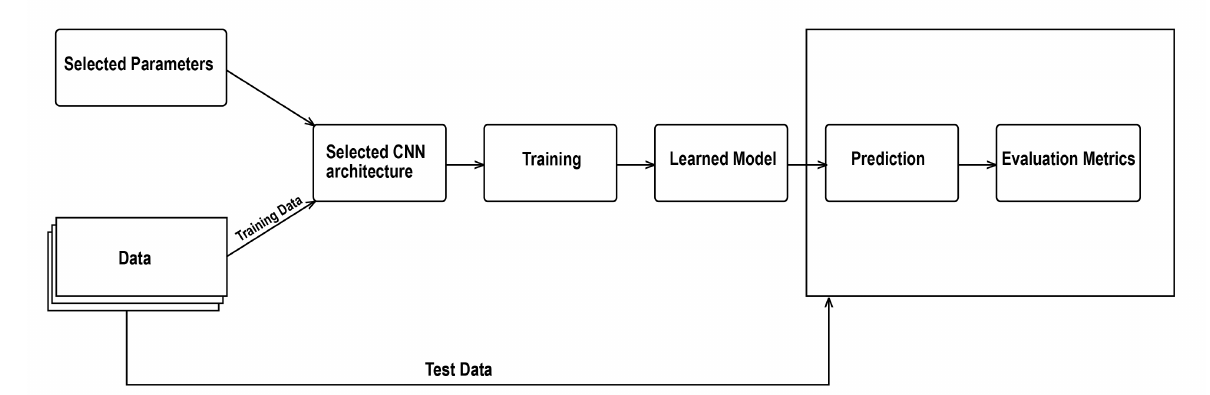
Figure 1. Workflow of the proposed